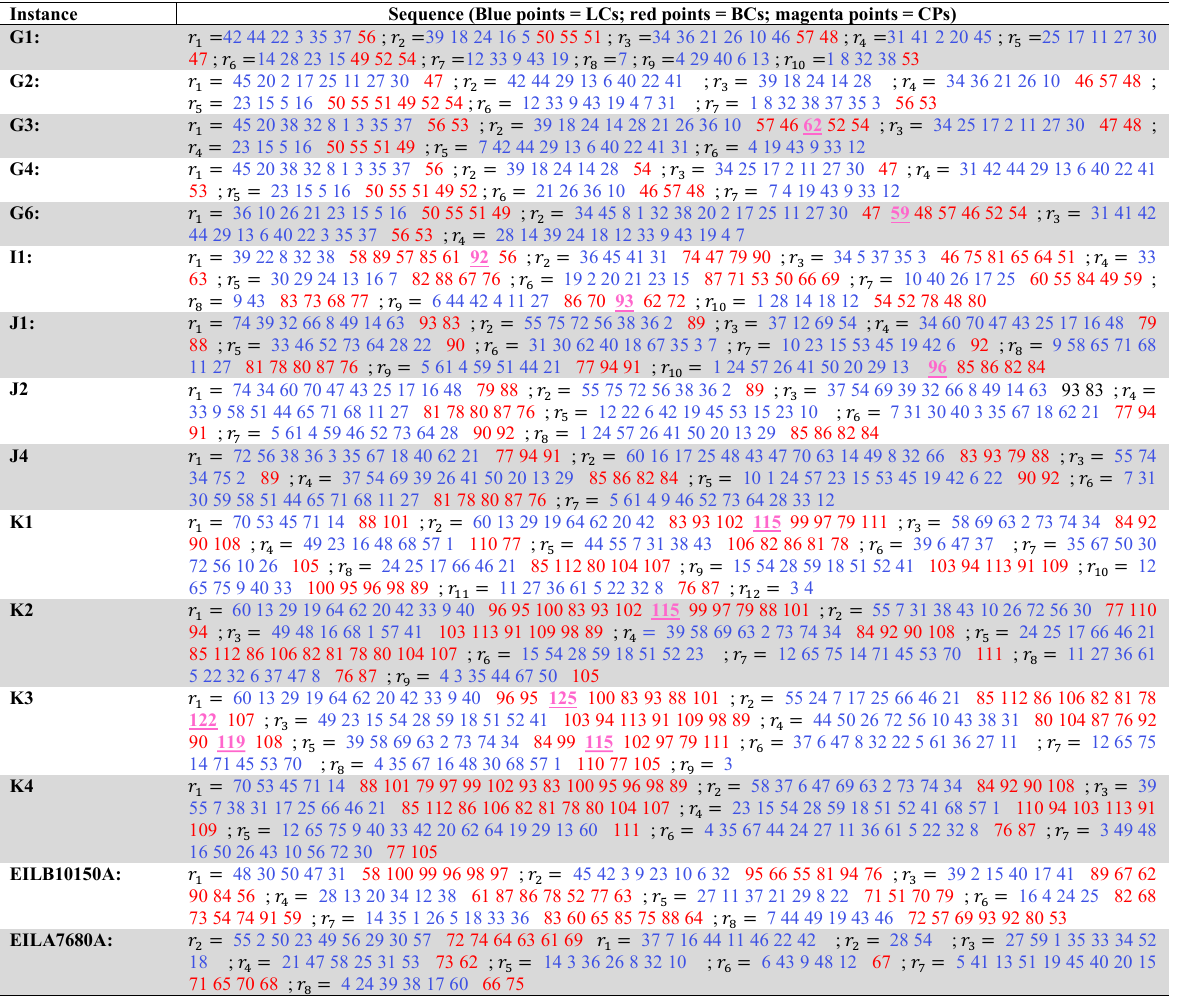
Detailed routes for the